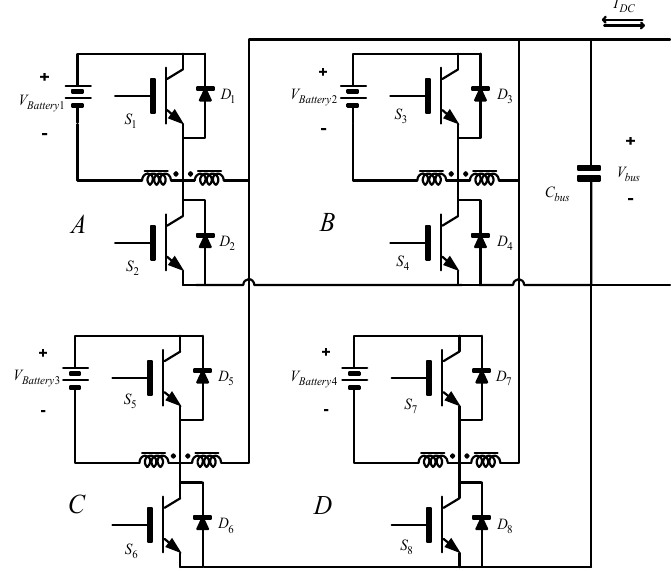
Figure 13. Four–Phase bi–directional flyback converter [27].